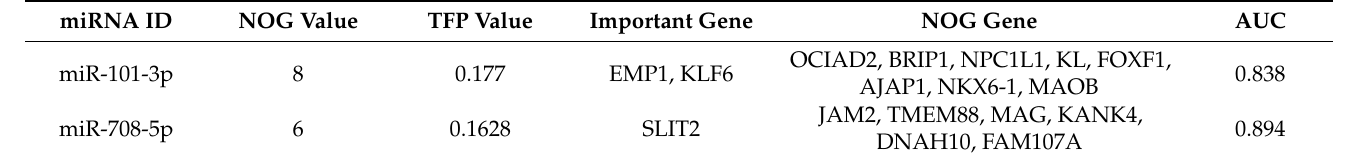
Table 1. MiRNAs obtained from the intersection of two screening methods in LUAD.